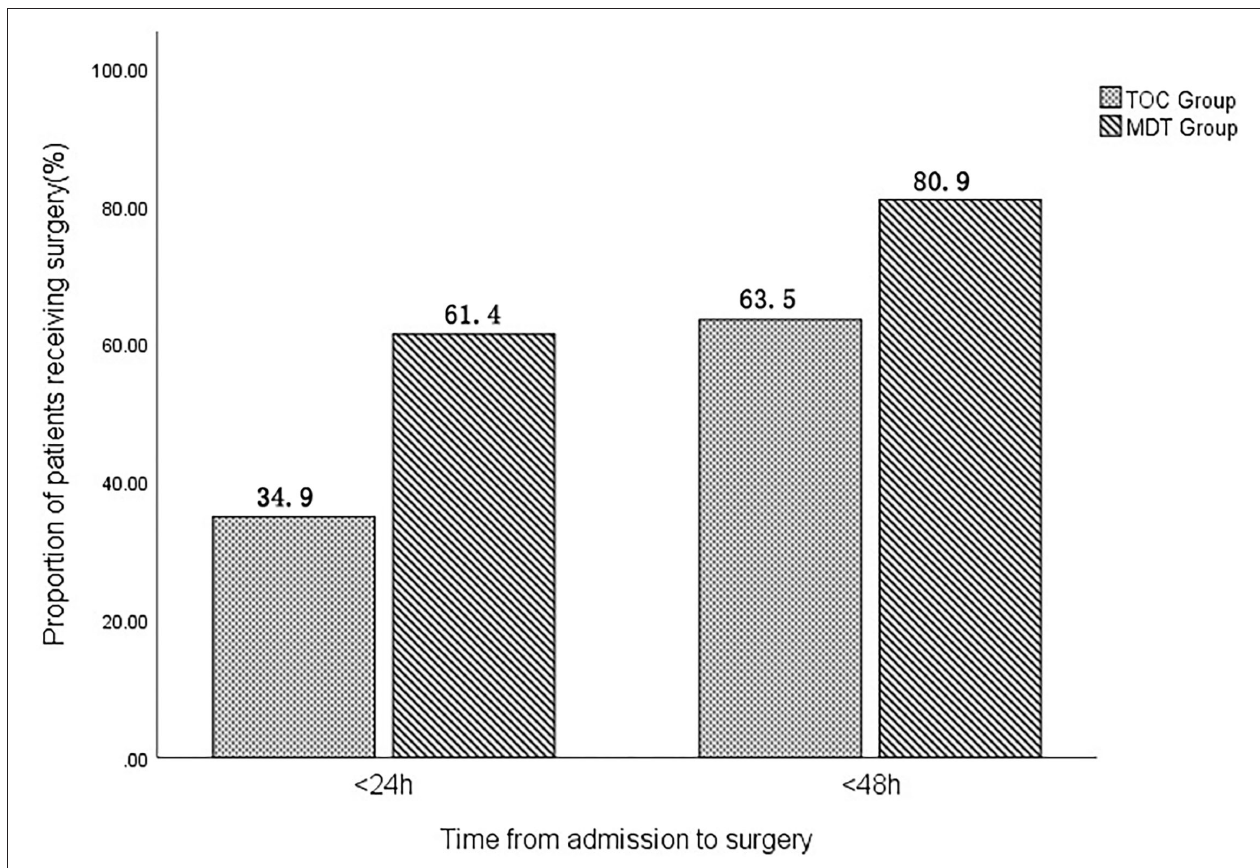
FIGURE 1 | The proportion of patients receiving surgery within 24 and